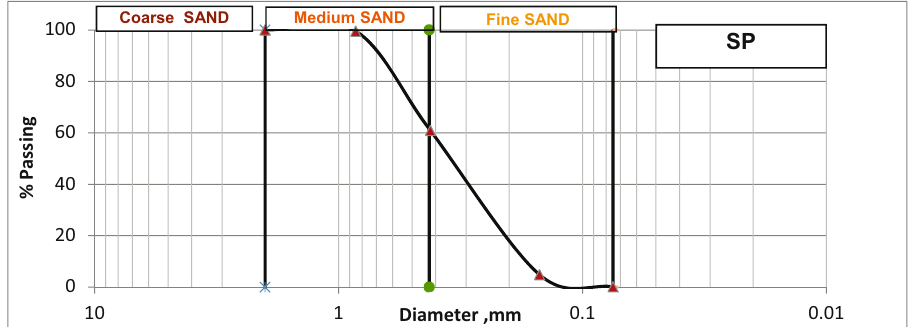
Figure 1: Grain size distribution curve.